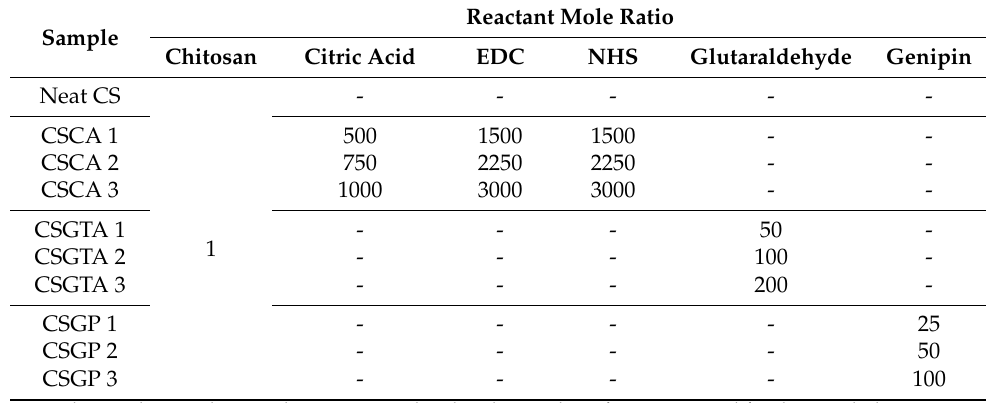
Table 1. The molar ratios of the reactants used for the crosslinking reactions.